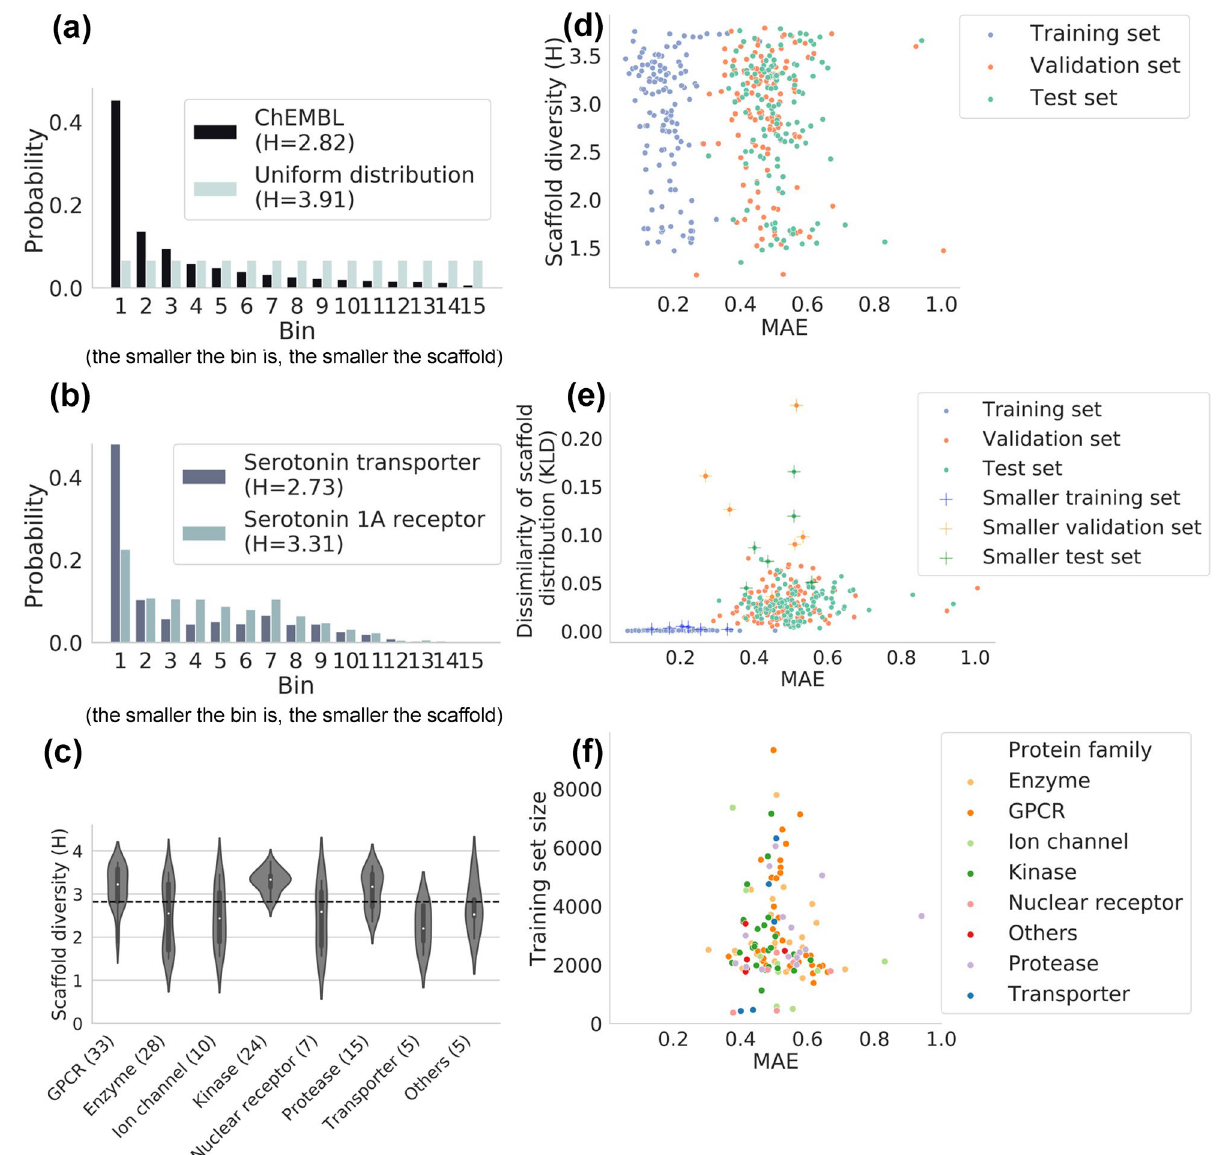
Figure 3. Effect of the scaffold diversity of the datasets on the prediction performance. ( a ) The probability distribution of the scaffolds in ChEMBL. Compared to the uniform distribution, ChEMBL is much more biased towards smaller scaffolds, resulting in a smaller H value. ( b ) The probability distribution of the scaffolds in the dataset for the serotonin transporter (SERT) and serotonin 1A receptor (5-HT1A). The H value is larger for 5-HT1A, whose scaffold distribution is wider than that of SERT. ( c ) Violin plots of the H value distribution by protein family. The number after each name on the x-axis shows the number of targets in each family. ( d – f ) Effect of the scaffold diversity ( d ), the dissimilarity of the scaffold distribution ( e ), and the training set size ( f ) on the